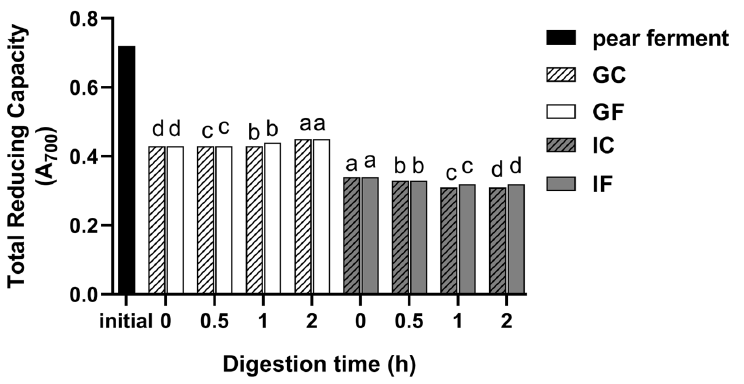
Figure 7. Changes of total reducing capacity of ‘Xuehua’ pear ferment during the simulated gastric and intestinal digestion in vitro. Different letters indicate significant differences in the same group under different digestion times ( p < 0.05). Data shown as means ± SD of three replicates ( n = 3).